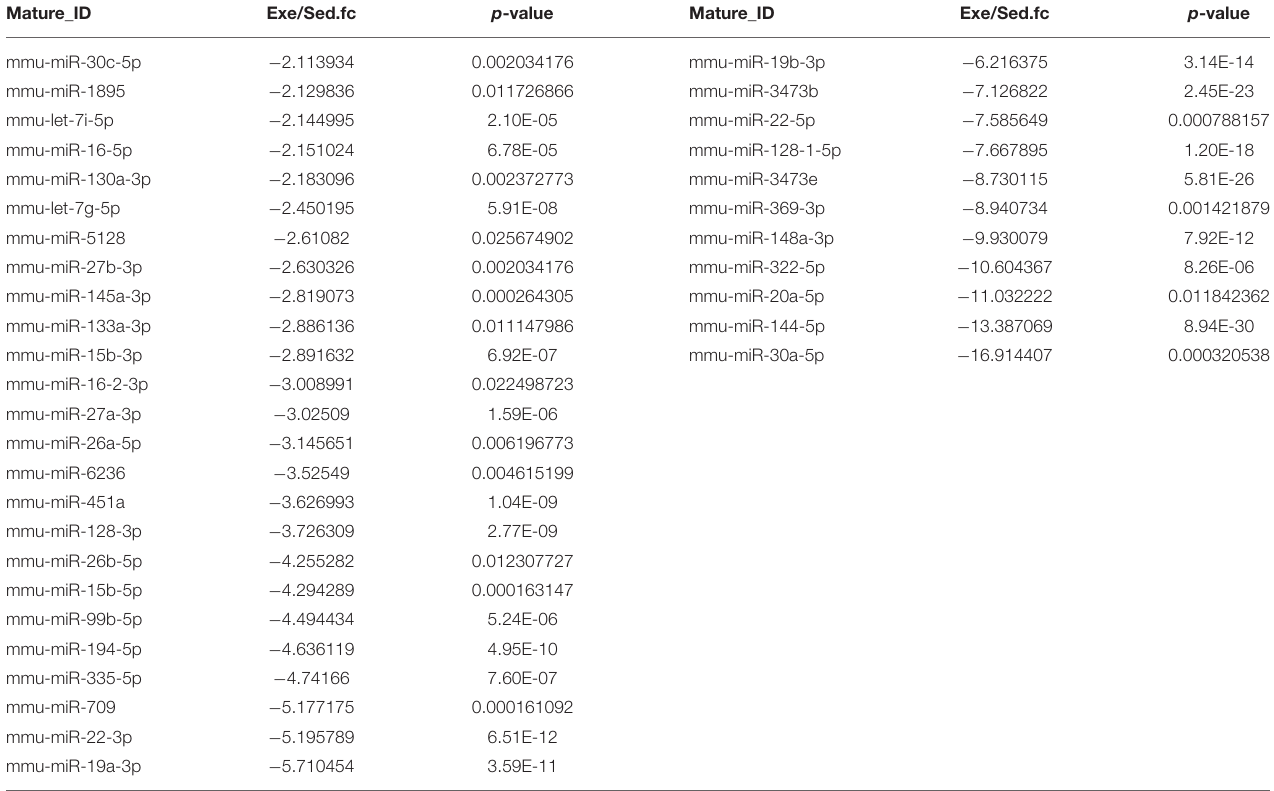
TABLE 2B | The list of downregulated miRNAs in 4 weeks of voluntary wheel exercise. Mature_ID Exe/Sed.fc p -value Mature_ID Exe/Sed.fc p